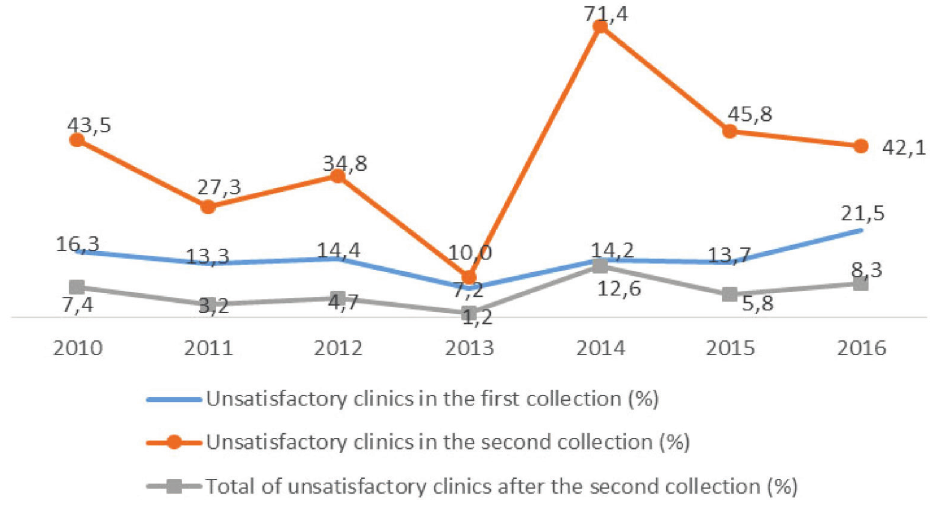
FIGURE 3 – Percentage of unsatisfactory results for the water sample collections in São Paulo State, Brazil, from 2010 to